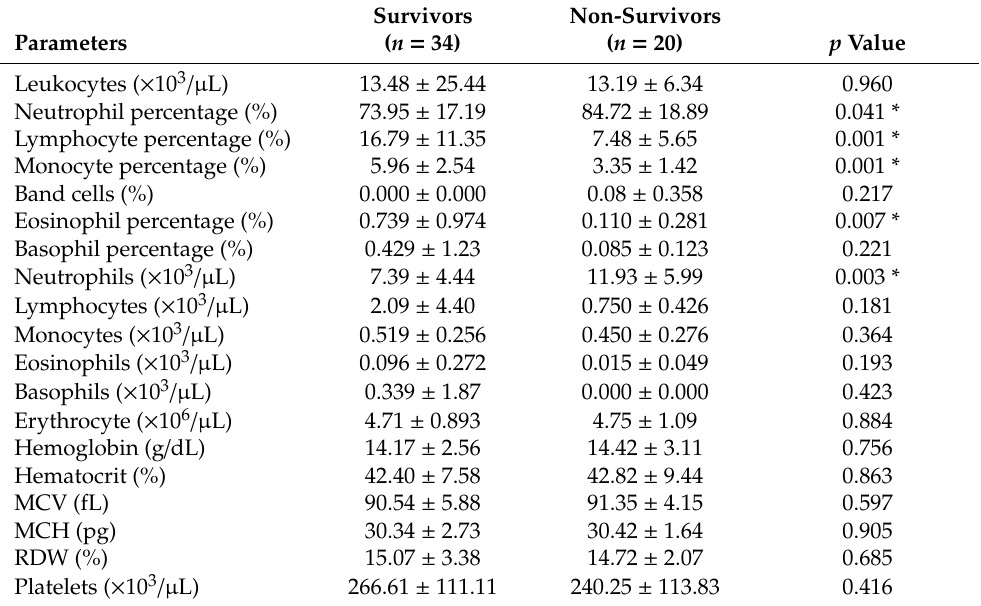
Table 4. Hematological parameters at admission in hospitalized patients with severe Covid-19. Abbreviations: MCV, mean corpuscular volume; MHC, mean corpuscular hemoglobin; RDW, red blood cell distribution. Normality of data distribution was estimated by the Shapiro–Wilk test. The unpaired Student’s t -test was used to compare numerical variables and data are presented as mean ± standard deviation. * Di ff erences were considered significant when p <